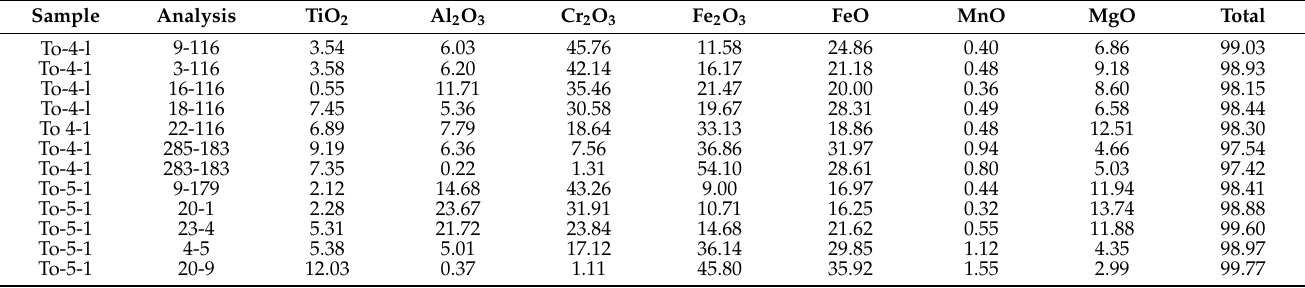
Table A4. Representative analyses of Cr–Ti-spinels and magnetites (all values in